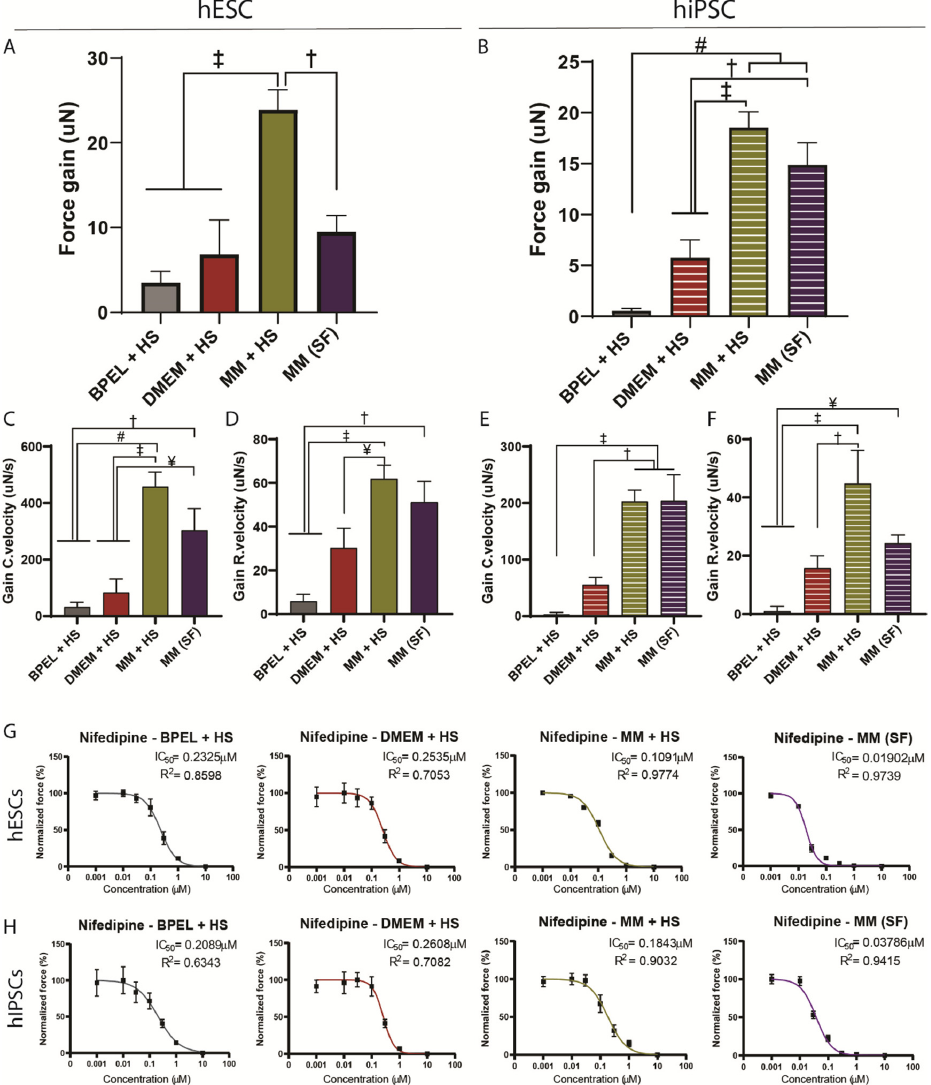
Figure 5. Response to inotropic agents in hESC and hiPSC-EHTs. ( A – D ) Absolute gain of contraction force of hESCs ( A ) and hiPSCs ( B ). EHTs in different media in response to isoproterenol (3 nM). ( C – F ) Absolute gain of contraction (Gain C.velocity) and relaxation (Gain R.velocity) velocity of hESCs ( C , D ) and hiPSCs ( E , F ). EHTs in different media in response to isoproterenol (3 nM). ( G , H ) Normal- ized force of contraction of hESCs ( G ) and hiPSCs ( H ). EHTs in different media in response to in- creasing concentrations of nifedipine (0–10 µM). ( A – F ) Data shown as one-way ANOVA plus Tukey’s test. Values are expressed as means ± SEM: ¥ = p < 0.05; † = p < 0.01; ‡ = p < 0.001; and # = p < 0.0001 ( N = 4, biological replicates from independent differentiations). HS, horse serum and SF, se- rum free.